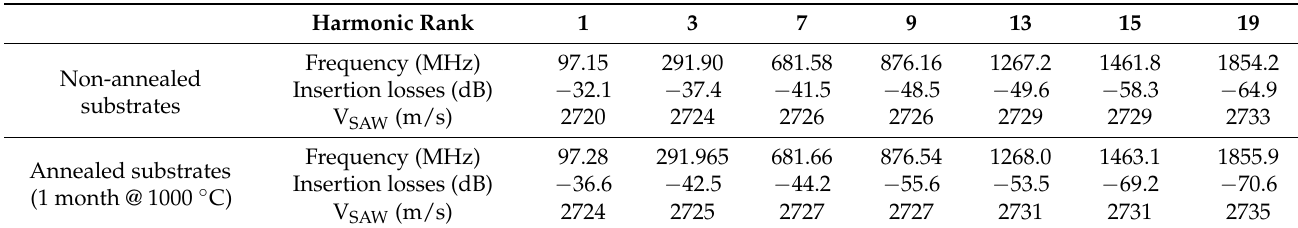
Table 2. Main results from SAW measurements.